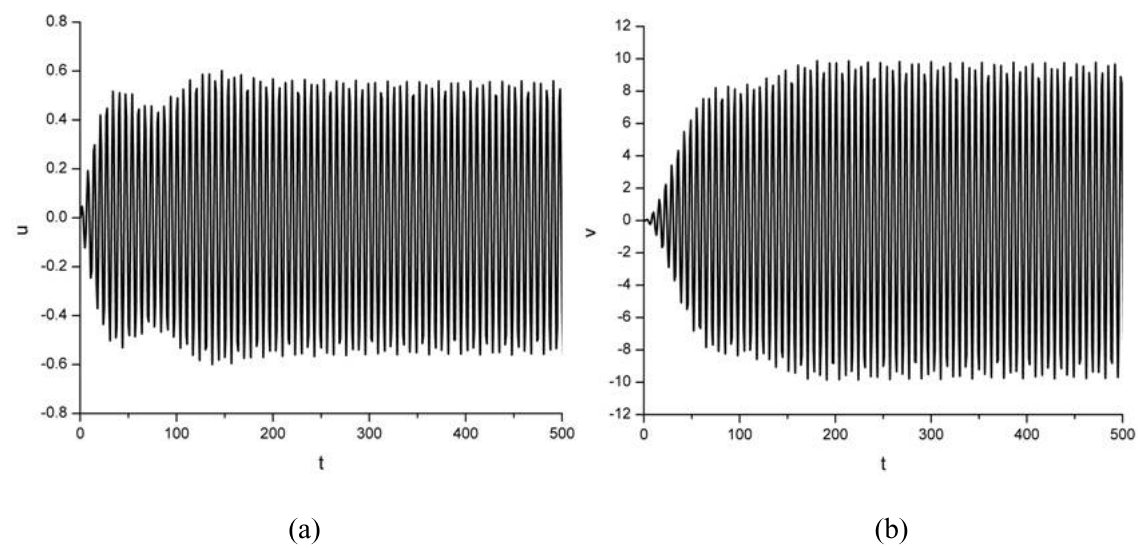
Fig. 20. Numerical simulation of the time response of (a) the plant and (b) the absorber when ω 2 = 0 . 97 , Ω = 0 . 95 and G = 0 . 002 .